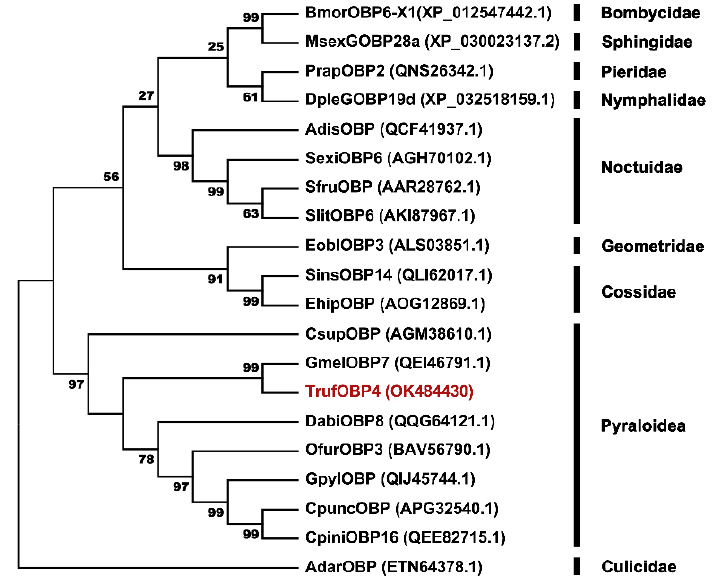
Figure 4. Phylogenetic tree of TrufOBP4 amino acid sequences with OBPs from other lepidopteran and dipteran insect species. The tree was constructed using the neighbor-joining method with a bootstrap of 1000 replicates. AdarOPB from Anopheles darlingi (Diptera: Culicidae) were used as the outgroup to root the tree. Anopheles darlingi (Adar), Athetis dissimilis (Adis), Bombyx mori (Bmor),